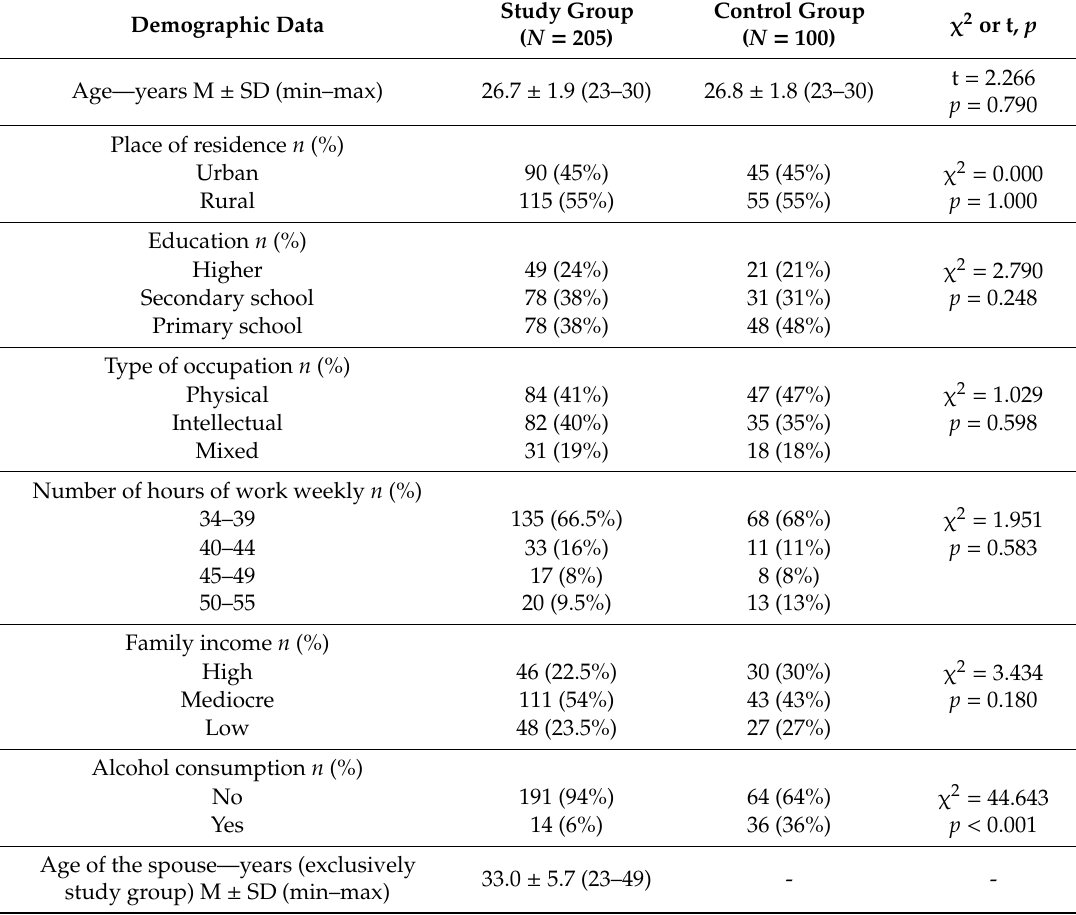
Table 1. Demographic characteristics of the examined